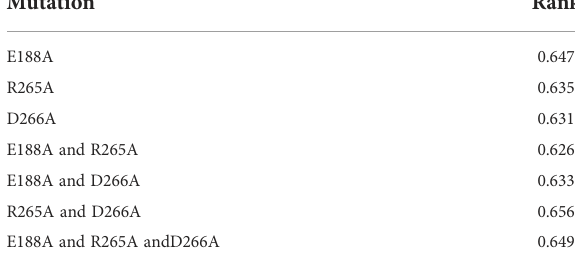
TABLE 2 Ranking results of Rg5 binding to P2RY 12 mutation variants.